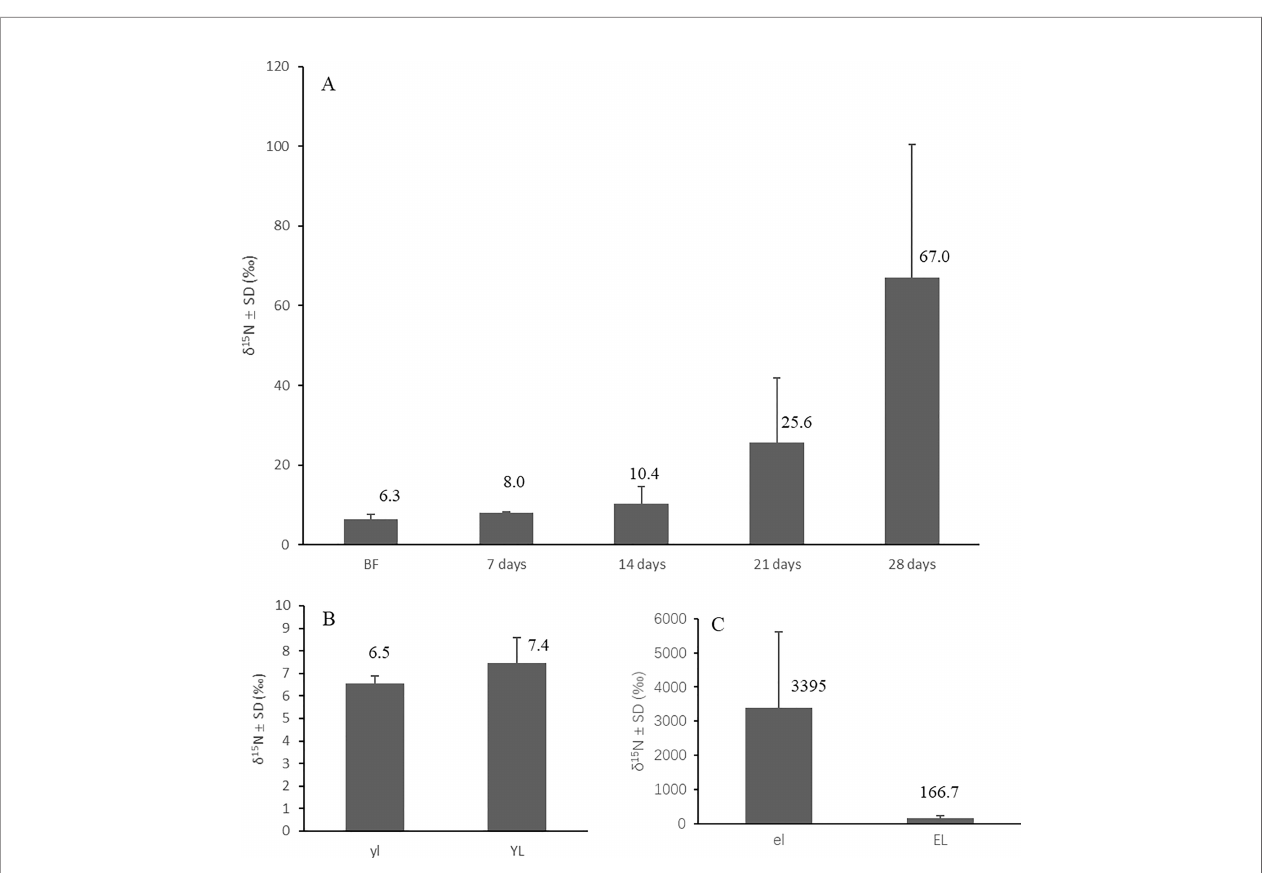
FIGURE 7 | Variation of tissue d 15 N of N. smithi with different treatments and experiment days, feeding on unenriched leaves in a 15 N-enriched atmosphere (A) , feeding in an unenriched atmosphere on unenriched leaves for 28 days (B) and 15 N-enriched leaves for 28 days (C) , respectively. BF, before feeding; el, 15 N- enriched leaves; EL, crabs feeding on 15 N-enriched leaves; yl, unenriched yellow leaves; YL, crabs feeding on unenriched yellow leaves.